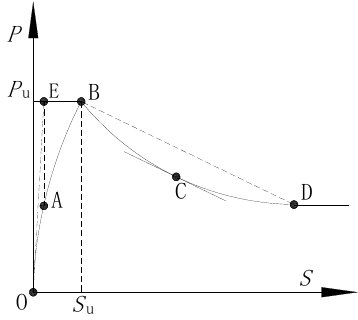
Figure 7. Method to defined characteristic point.